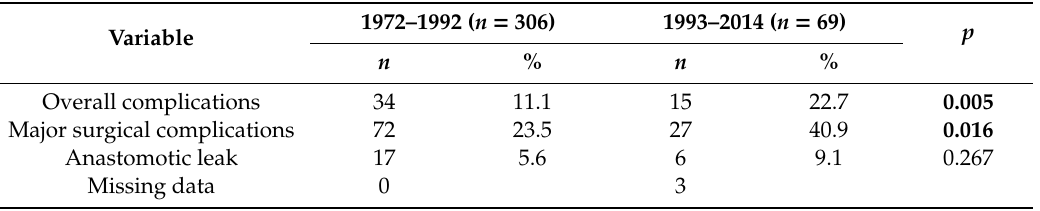
Table 5. Patients with splenectomy.